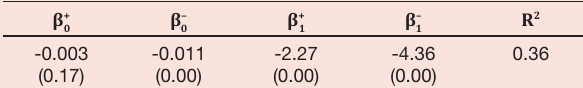
India VIX Nifty 50 ( )right scale Source: